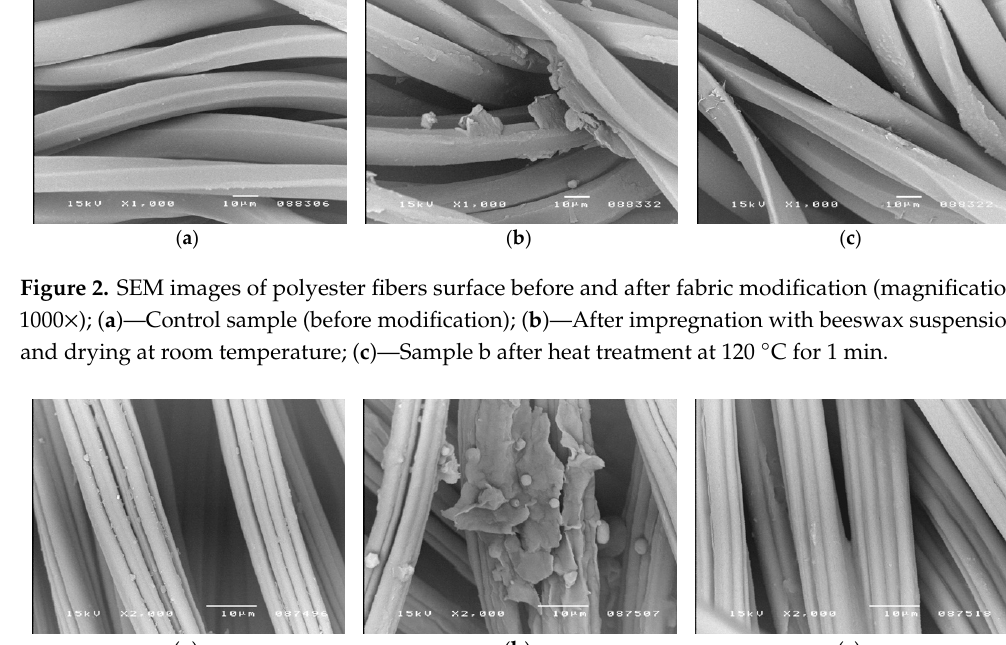
Figure 1. Scanning electron microscope (SEM) images of cotton fibers surface before and after fabric modification (magnification 2000×); ( a )—Control sample (before modification); ( b )—After impregnation with beeswax suspension and drying at room temperature; ( c )—Sample b after heat treatment at 120 °C for 1 min.